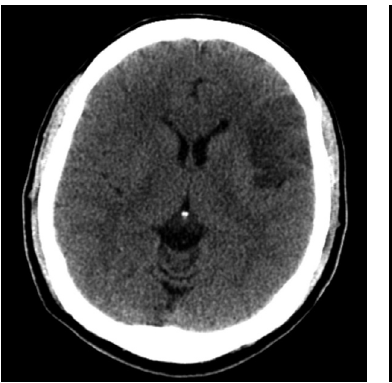
Figure 2. Brain Magnetic Resonance Imaging (FLAIR) in axial section showing hypersignal in the left an- terior and posterior insular cortex topography, with sparing of the left angular and supramarginal gyri.